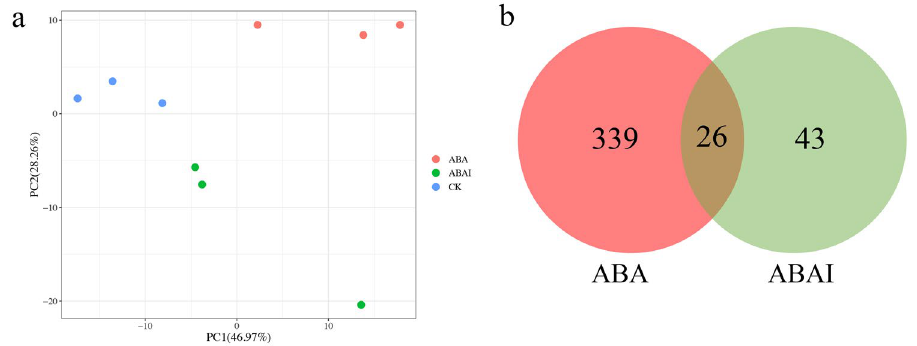
Figure 2. Overview of quantitative proteomic data. ( a ) PCA of proteins in the CK, ABA and ABAI groups. ( b ) Venn diagram of DAPs in cotton ovules treated with ABA and ABAI.